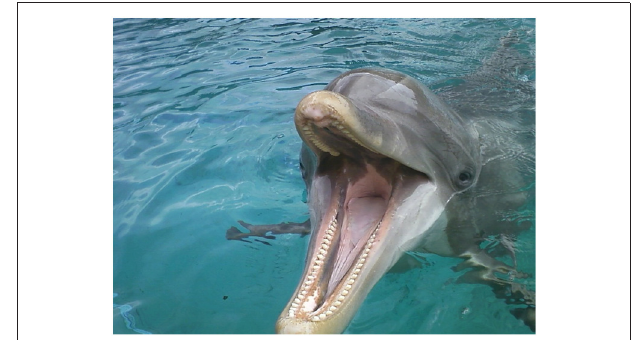
FIGURE 3 | A dolphin begging for an ice cube ( © B.